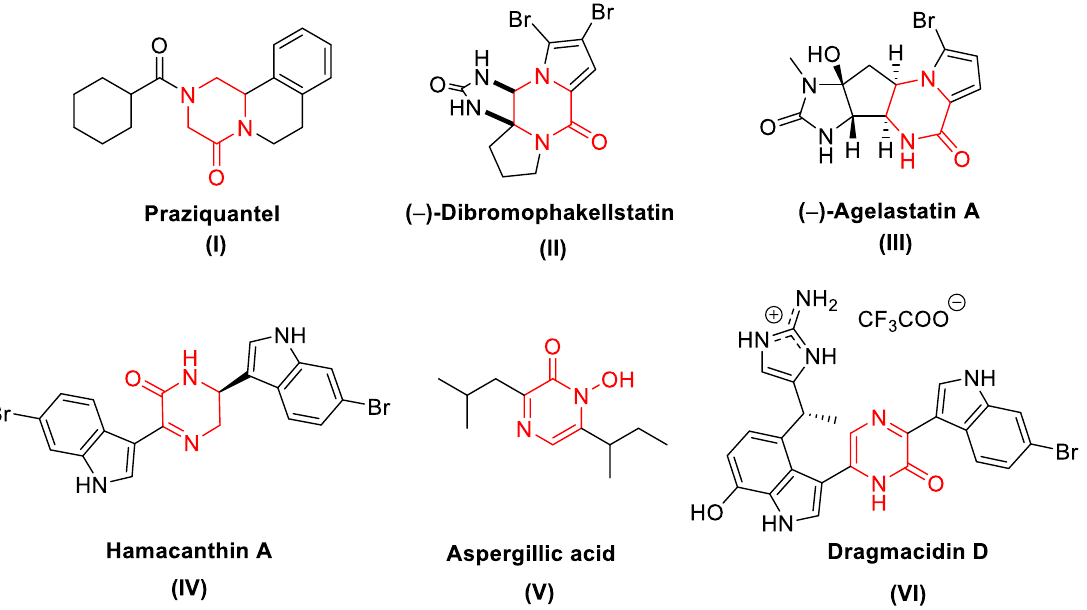
Figure 1. Bioactive natural products containing piperazinone, 5,6-dihydropyrazin-2(1 H )-one, and pyrazin-2(1 H )-one scaffolds.